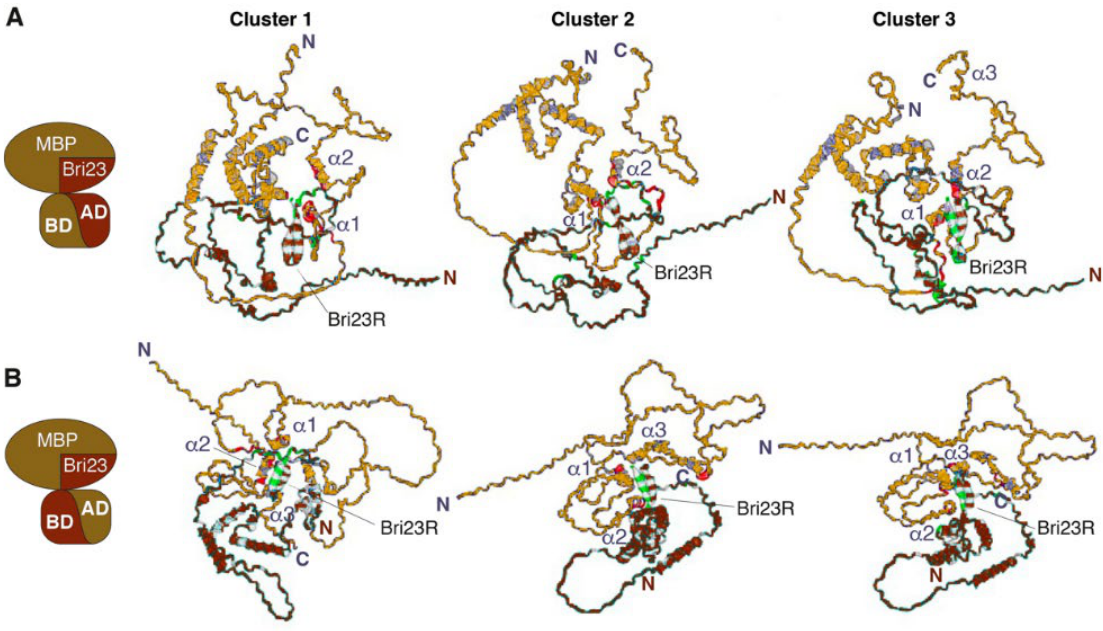
Figure 3. HADDOCK-predicted complexes Gal4BD-MBP/Gal4AD-Bri23R ( A ) and Gal4AD- MBP/Gal4BD-Bri23R ( B ). The representative structures of lowest energy clusters (see Table 2 for description) obtained for the best 30 HADDOCK-generated complexes are shown as ribbon-mesh pictograms generated by PDBePISA. MBP-containing fusion proteins are colored gold, while Bri23R-containing fusion proteins are colored brown (see pictograms at the left for illustration); the main chains of interacting residues from the binding interfaces are marked by red and green color, respectively.